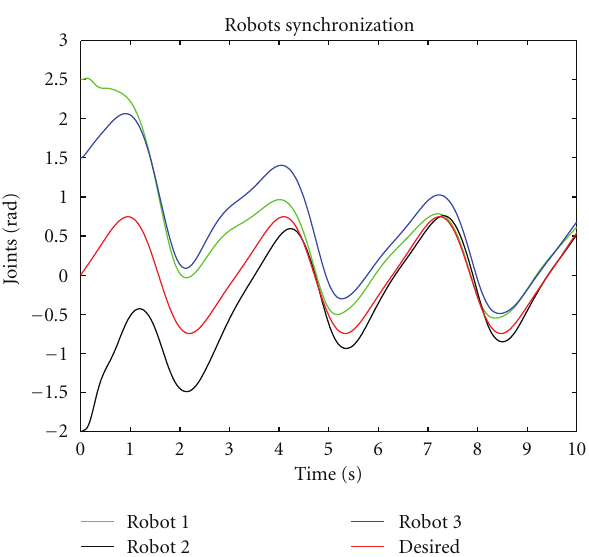
Figure 6: Synchronization errors.